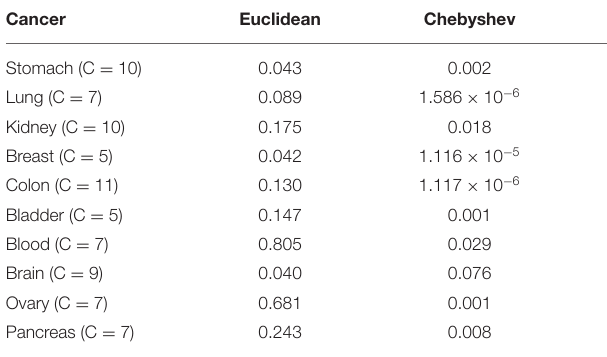
TABLE 3 | Comparing SKF with different